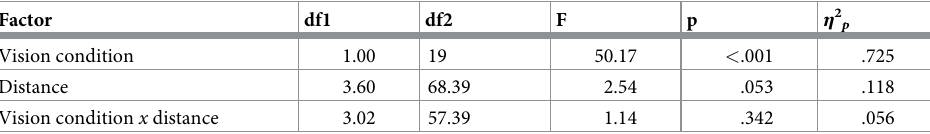
Table 11. Results of the two-factor ANOVA with repeated measures (6 distances; 2 vision conditions) for the response time. Corrected by Greenhouse-Geisser � . Factor df1 df2 F p η 2 p Vision condition 1.00 19 50.17 < .001 .725 Distance 3.60 68.39 2.54 .053 .118 Vision condition x distance 3.02